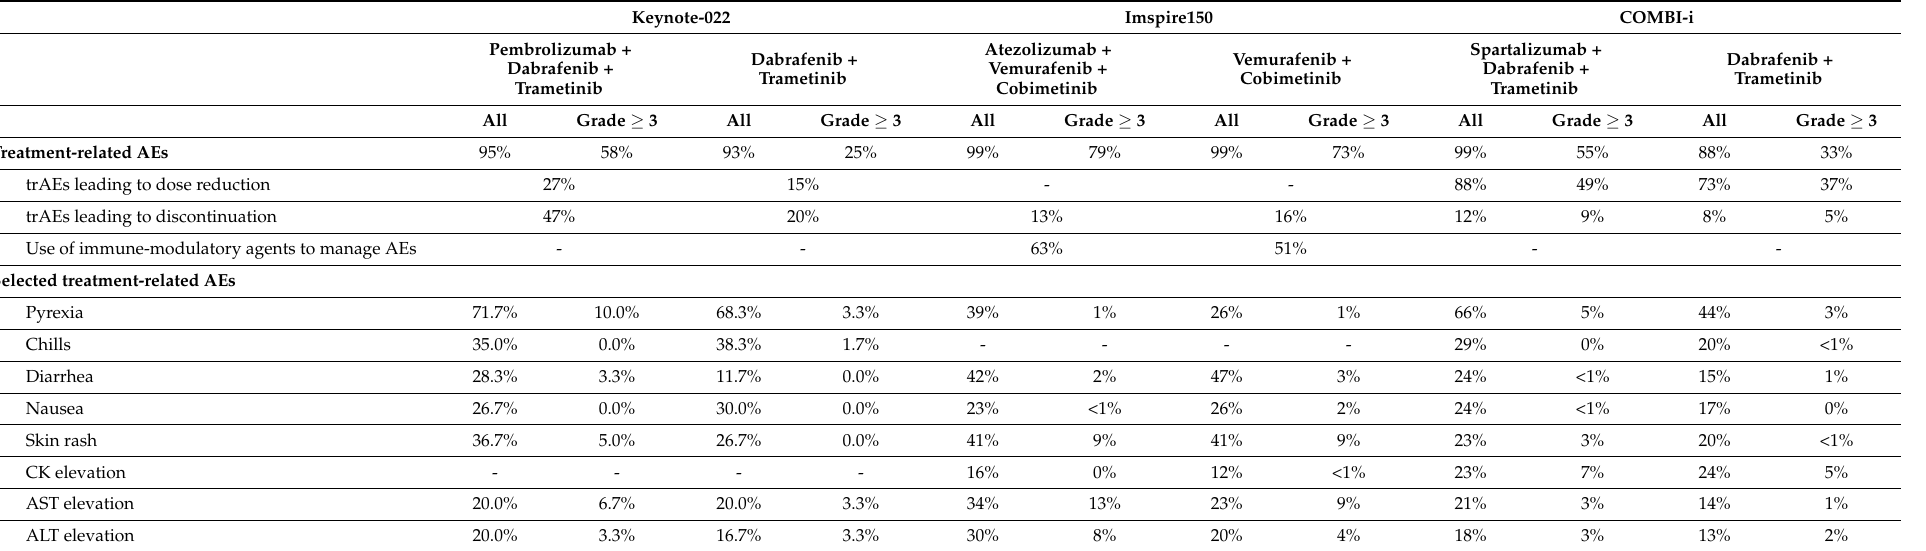
Table 2. Toxicity profile of combination triple therapy vs. double